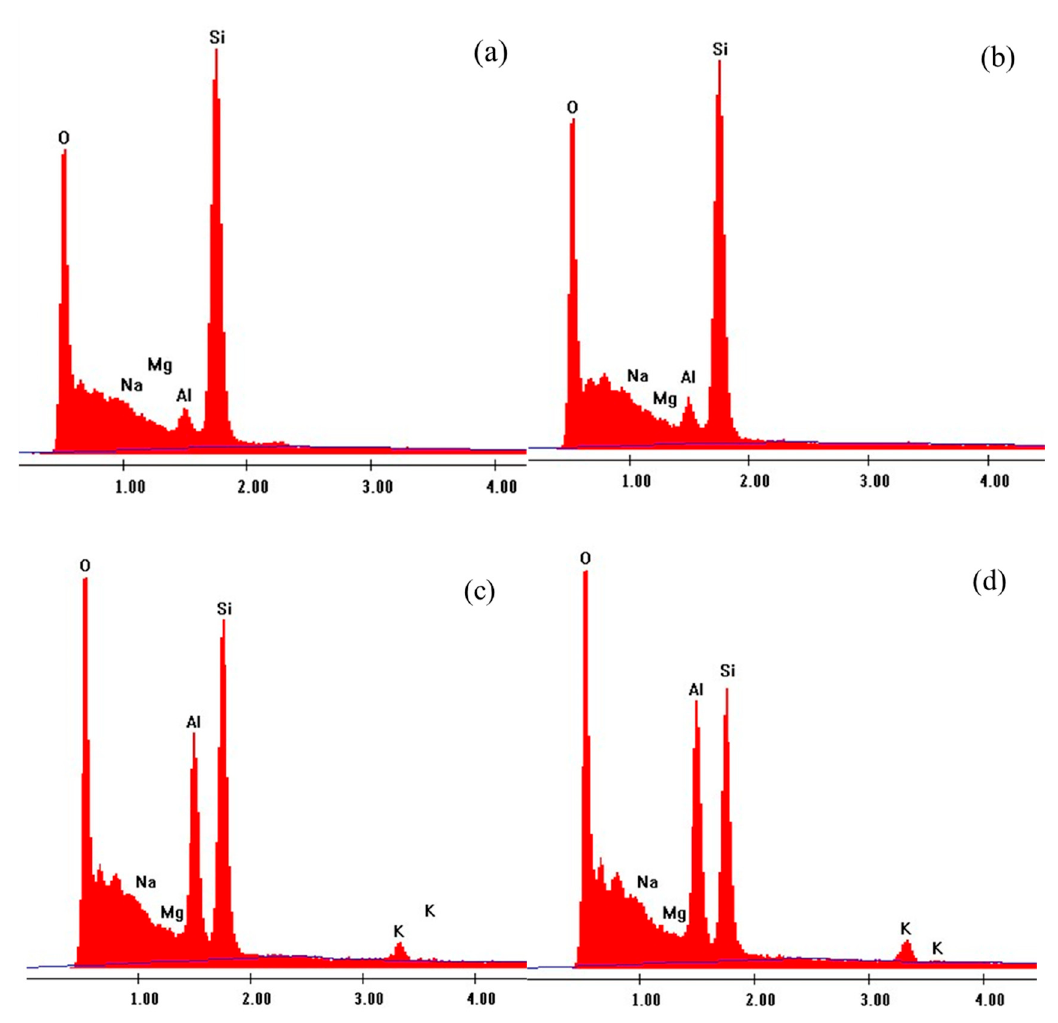
Figure 3. Typical EDS graphs of coated LBS grains at different concentrations: ( a ) 50 mg/mL; ( b ) 100 mg/mL; ( c ) 200 mg/mL; ( d ) 300 mg/mL.